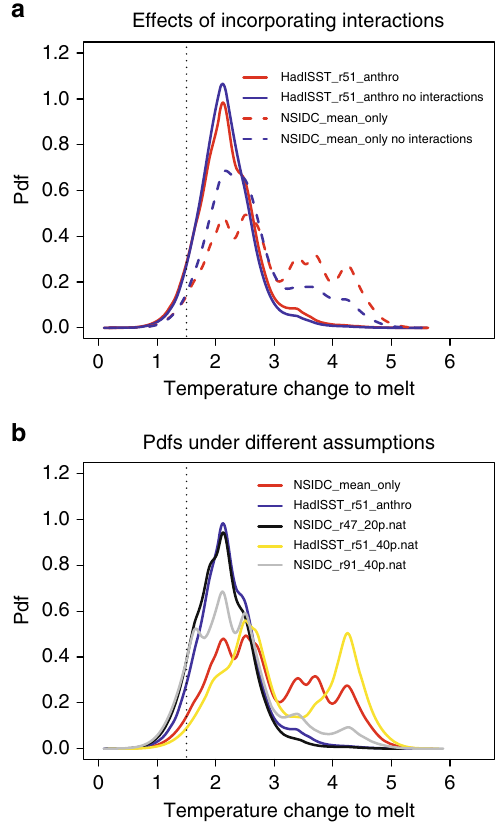
Fig. 4 Probability density functions (pdfs) of global mean surface temperature change required for September Arctic sea ice to effectively vanish. a Pdfs for runs with and without interactions (to illustrate the effects of accounting for model interactions). b Pdfs from all runs accounting for interactions, to illustrate the impact of different assumptions. Vertical dotted line: lower desirable warming limit of 1.5°